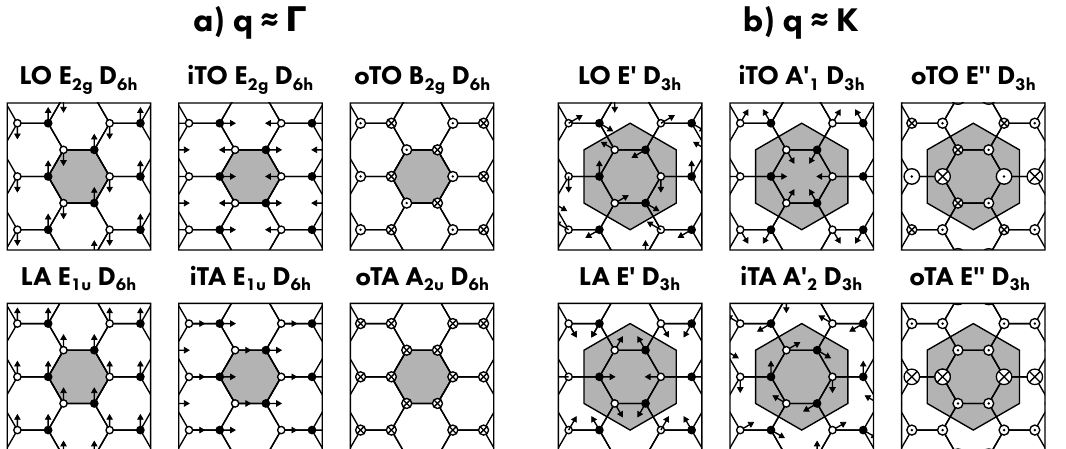
Figure 15. Phonon modes of single-layer graphene at wavevector equal to ( a ) q ≈ Γ and ( b ) q ≈ K . Each mode is indicated by the symmetry of wavevector, the space group label in Mulliken notation, and by the type of the corresponding atom displacement. Adapted with permission from Ref.